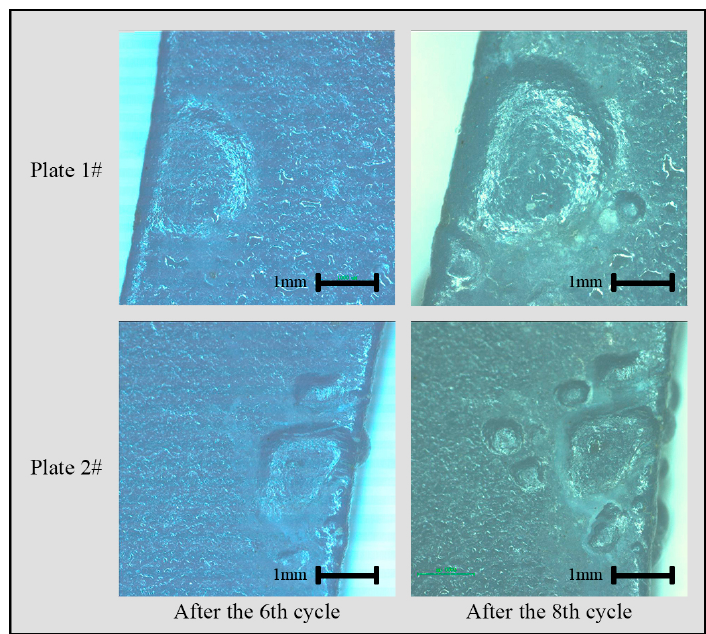
Figure 4. Micro-morphology of the specimens.